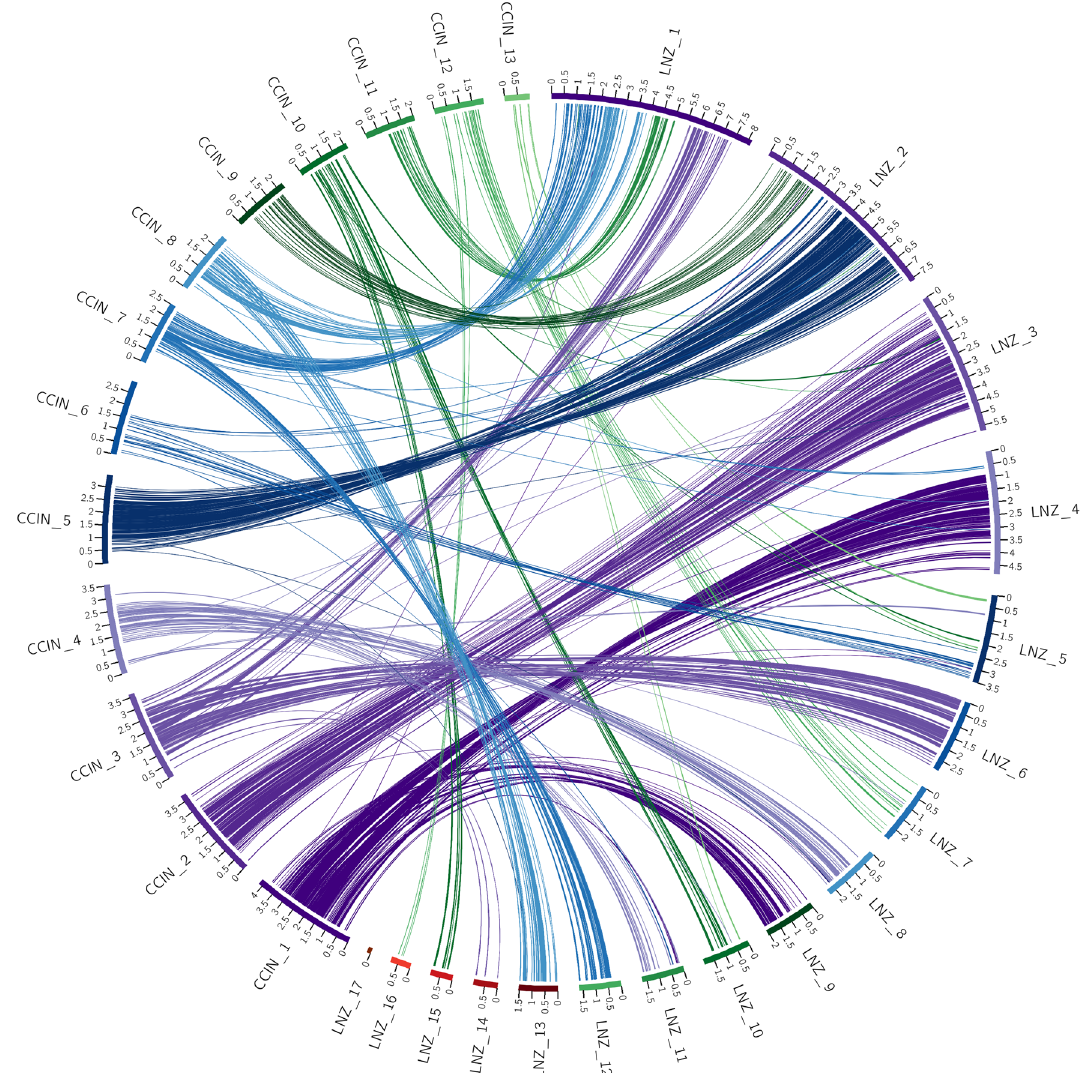
Figure 1. Circos plot of shared syntenic regions between C. cinerea and L. novae-zelandiae ICMP 18003. Syntenic regions are connected with colored ribbons scaled to the size of the syntenic regions. These ribbons match the colors of the C. cinerea scaffold blocks. Genomic scaffold lengths are in Mb and are indicated by the numerals on each